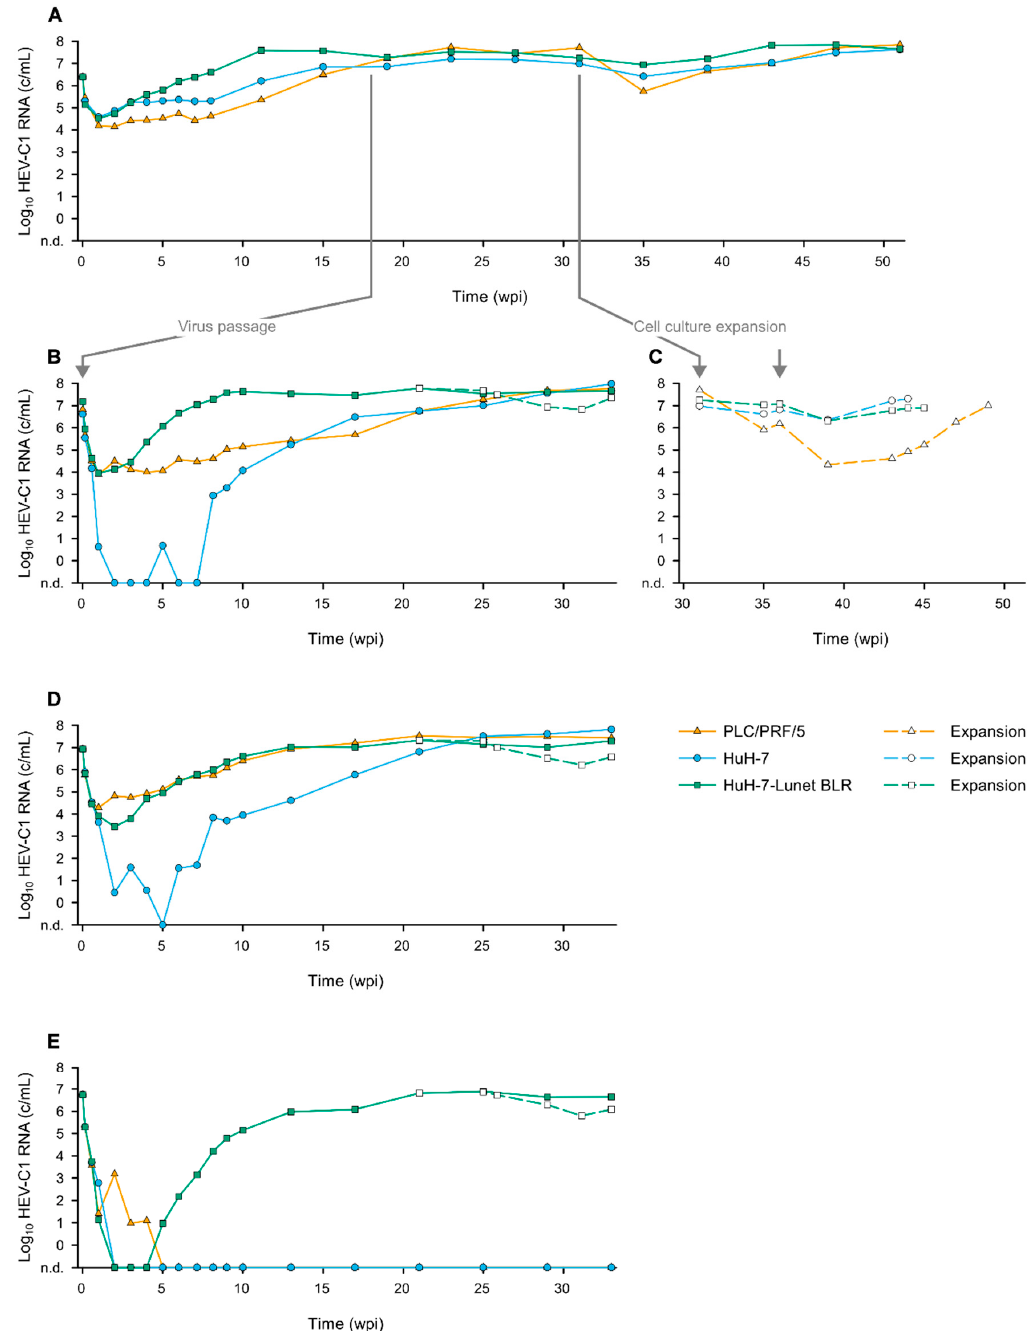
Figure 1. Replication dynamics of the rat HEV (HEV ‐ C1) in different human liver carcinoma cell lines. ( A ) PLC/PRF/5, HuH ‐ 7, and HuH ‐ 7 ‐ Lunet BLR were inoculated with the PLC/PRF/5 cell culture supernatant positive for HEV ‐ C1 strain R63. Supernatants of all three cell lines were collected on day 126 post inoculation and used to ( B ) passage the virus in a cell line ‐ specific manner, meaning that the HEV ‐ C1 strain R63 positive PLC/PRF/5, HuH ‐ 7, and HuH ‐ 7 ‐ Lunet BLR cell culture supernatants were inoculated onto PLC/PRF/5, HuH ‐ 7, and HuH ‐ 7 ‐ Lunet BLR, respectively. ( C ) The HEV ‐ C1 strain R63 positive cell cultures from the first inoculation were expanded from T12.5 to T75 flasks and a second time from T75 to T175 flasks. As soon as the initial viral load was reached again in the supernatant, the cells were detached and aliquots stored at − 192 °C. ( D ) R63 passage 6 (derived from PLC/PRF/5) and ( E ) R68 positive liver homogenate were also inoculated onto PLC/PRF/5, HuH ‐ 7, and HuH ‐ 7 ‐ Lunet BLR.